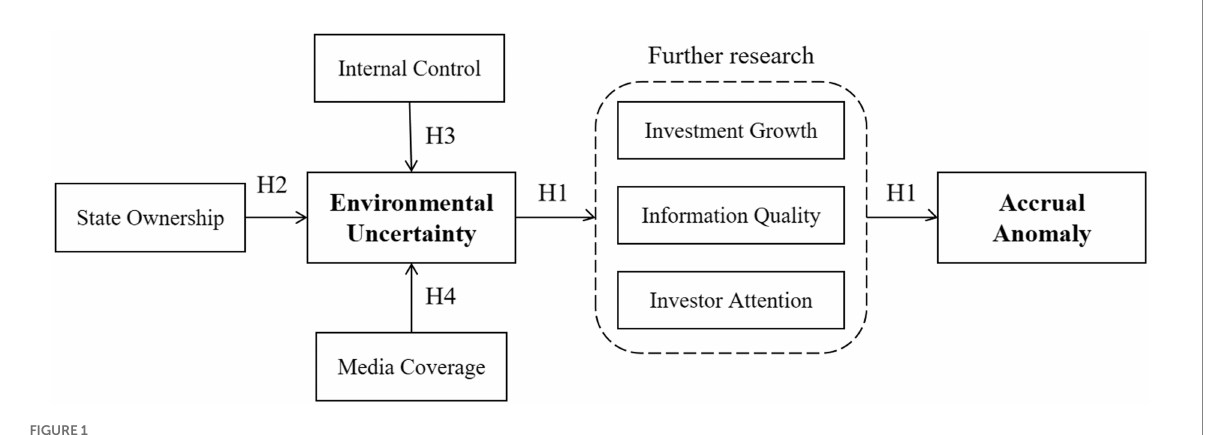
FIGURE 1 The logical framework